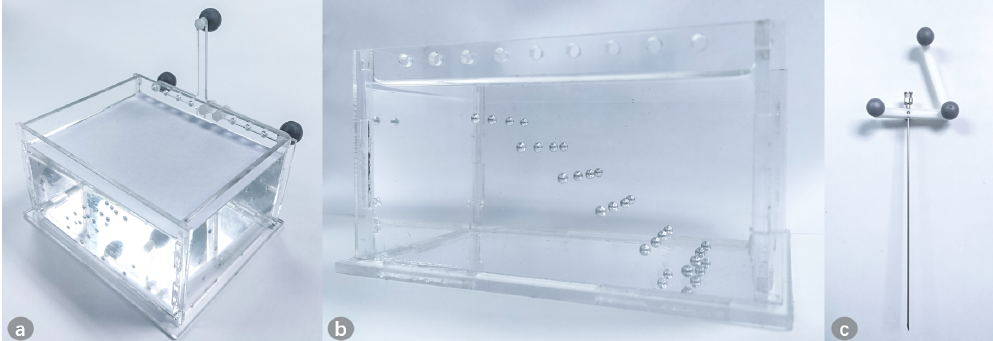
Figure 11. The model for puncture. ( a ) The model is fixed with the marker, and is covered to ensure that the surgeon cannot see the internal lesion information from above; ( b ) The lesions are placed at different depths, and the side of the model is transparent to check whether the needle successfully reaches the lesion; ( c ) The puncture needle is fixed with the 3D-printed